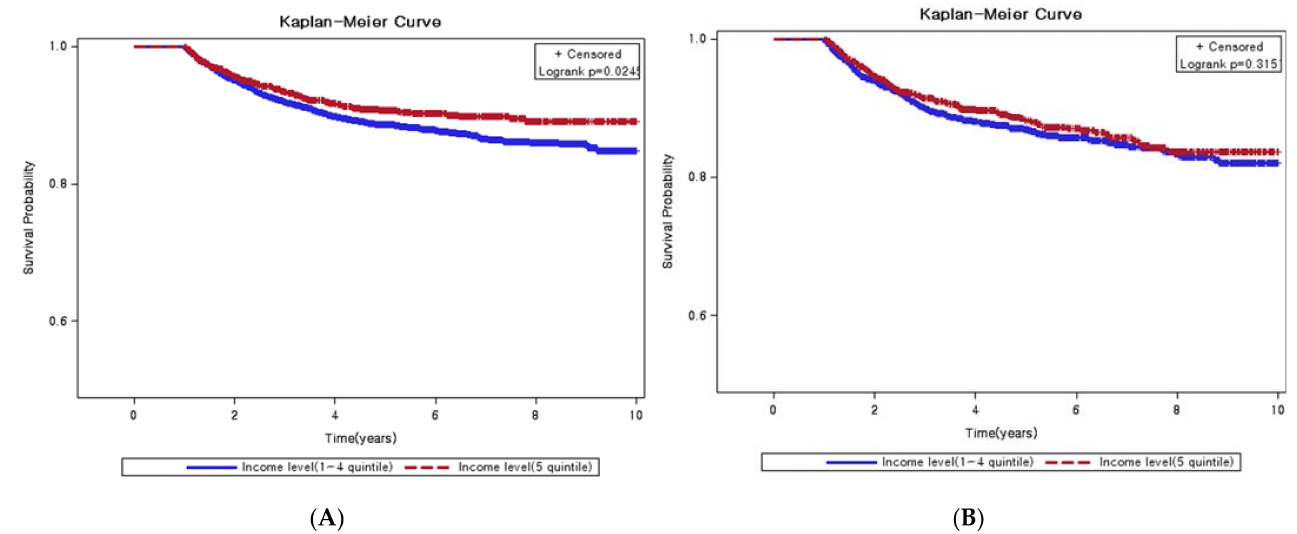
Figure 2. Kaplan–Meier curve of cancer patients for ten years according to income level by utilization in the capital. ( A ) Patients not utilized in the capital; ( B ) Patients utilized in the